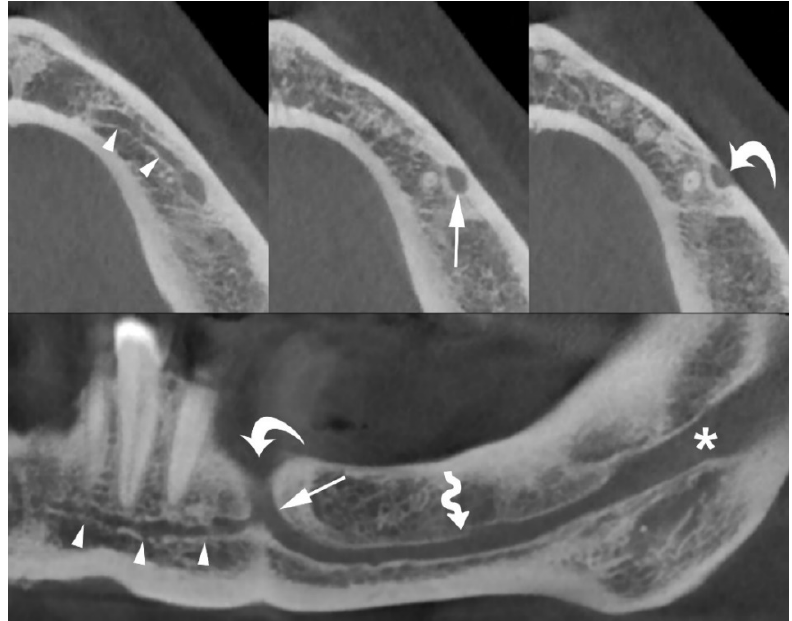
Figure 1. Axial ( top ) and panoramic ( bottom ) cone-beam computed tomography (CBCT) images of the left hemi-mandible demonstrate that the mandibular incisive canal (MIC) (arrowheads) originates from the anterior loop of mandibular canal (arrows) and proceeds towards the midline below the apices of the teeth. The mental foramen (curved arrows), mandibular canal (wavy arrow), and mandibular foramen (asterisk) are also shown.